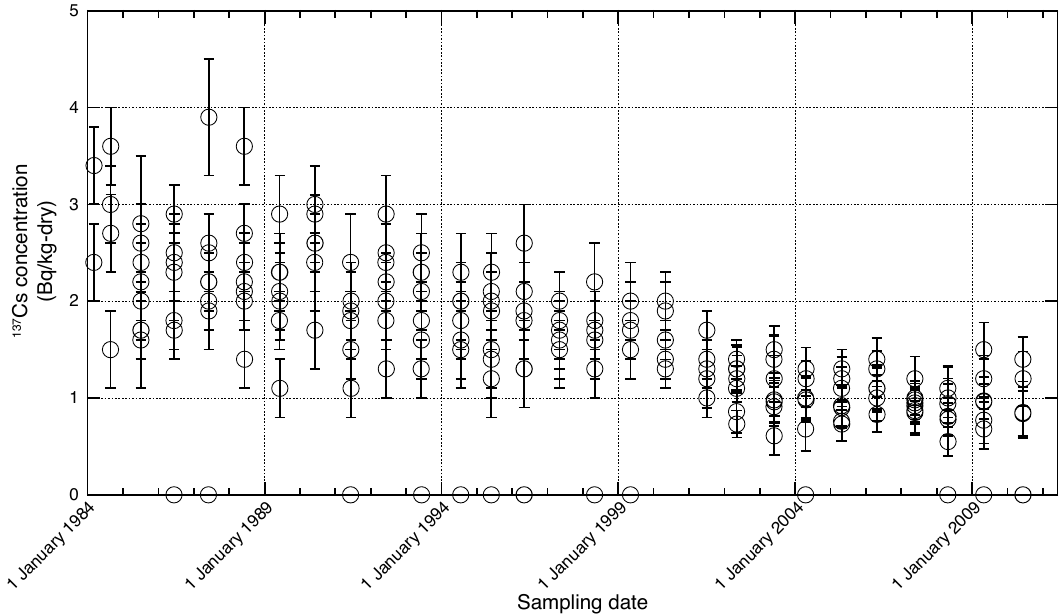
Fig. 1. Temporal variation of 137 Cs concentrations in surface sediments collected from the Pacific Ocean off the Fukushima Dai-ichi and Dai-ni Nuclear Power Plants prior to 2011 (1984–2010). The data plotted in the figure were obtained from MEXT (2011). Eight sampling stations were located about 30km off the coast. The open circles on the x axis indicate the concentrations were below the detection